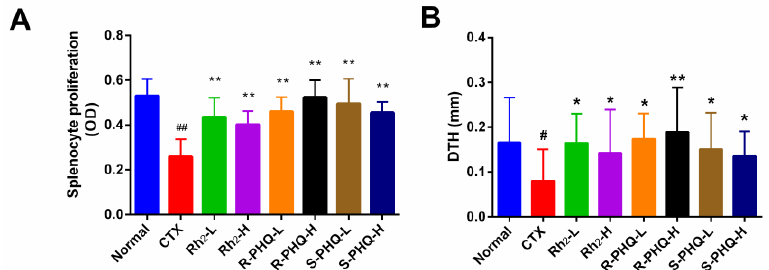
Figure 2. Effect of Rh 2 , R-PHQ, and S-PHQ on the ( A ) ConA-induced splenocyte proliferation and ( B ) SRBC induced DTH. The values are presented as mean ± SD, n = 10. ## p < 0.01 and # p < 0.05 compared with the normal group. ** p < 0.01 and * p < 0.05 compared with the CTX group. Effect of Rh 2 , R-PHQ, and S-PHQ on Delayed-Type Hypersensitivity (DTH) to Sheep Red Blood Cells